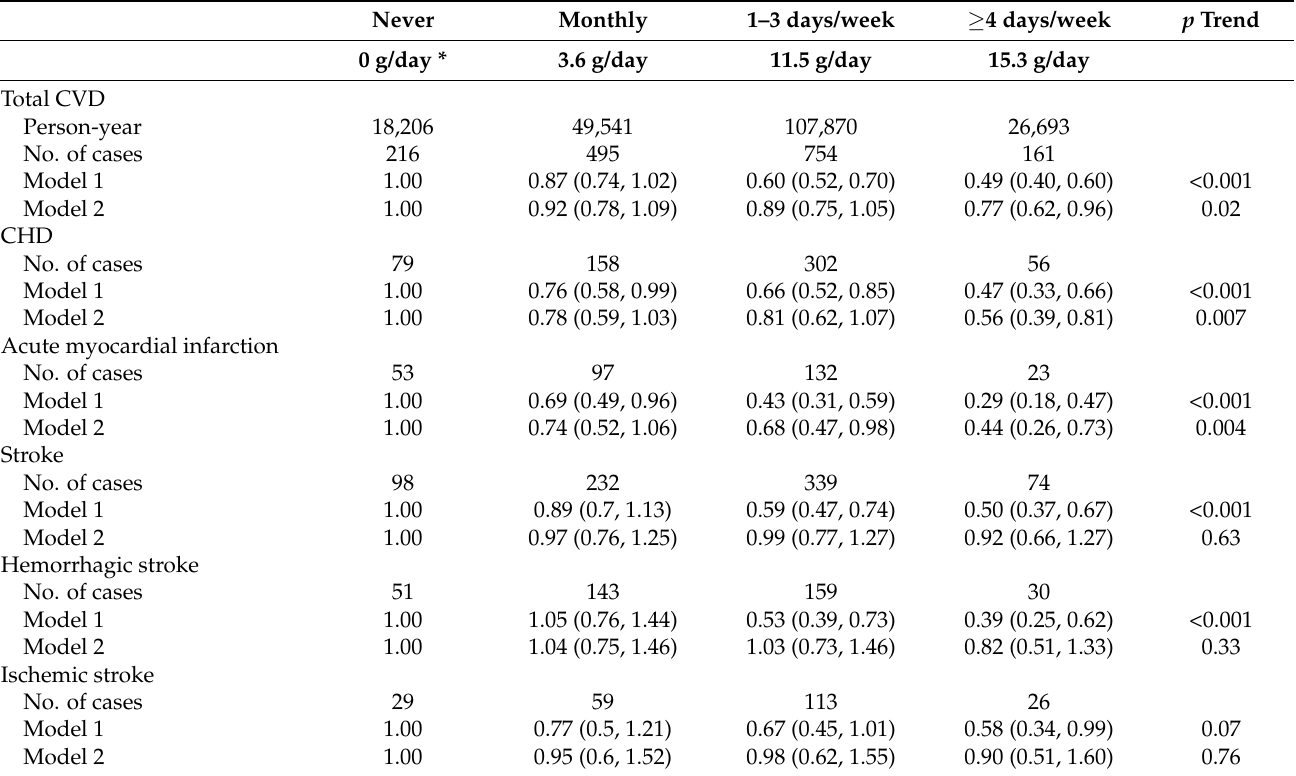
individuals who never consumed soy foods, the multivariable-adjusted risks (95% CIs) of CVD mortality were 0.92 (0.78, 1.09), 0.89 (0.75, 1.05), and 0.77 (0.62, 0.96) for those who consumed soy monthly, 1–3 days/week, and ≥ 4 days/week, respectively. Among cause-specific CVD mortality, this inverse association with soy consumption was evident for CHD (HR = 0.56 (0.39, 0.81) for regular consumers) and acute myocardial infarction (HR = 0.44 (0.26, 0.73) for regular consumers). Soy consumption was not associated with risk of death from stroke and stroke subtypes (Table 2). Table 2. Soy consumption and risk of cardiovascular mortality in Chinese adults with type 2 diabetes. Never Monthly 1–3 days/week ≥ 4 days/week p